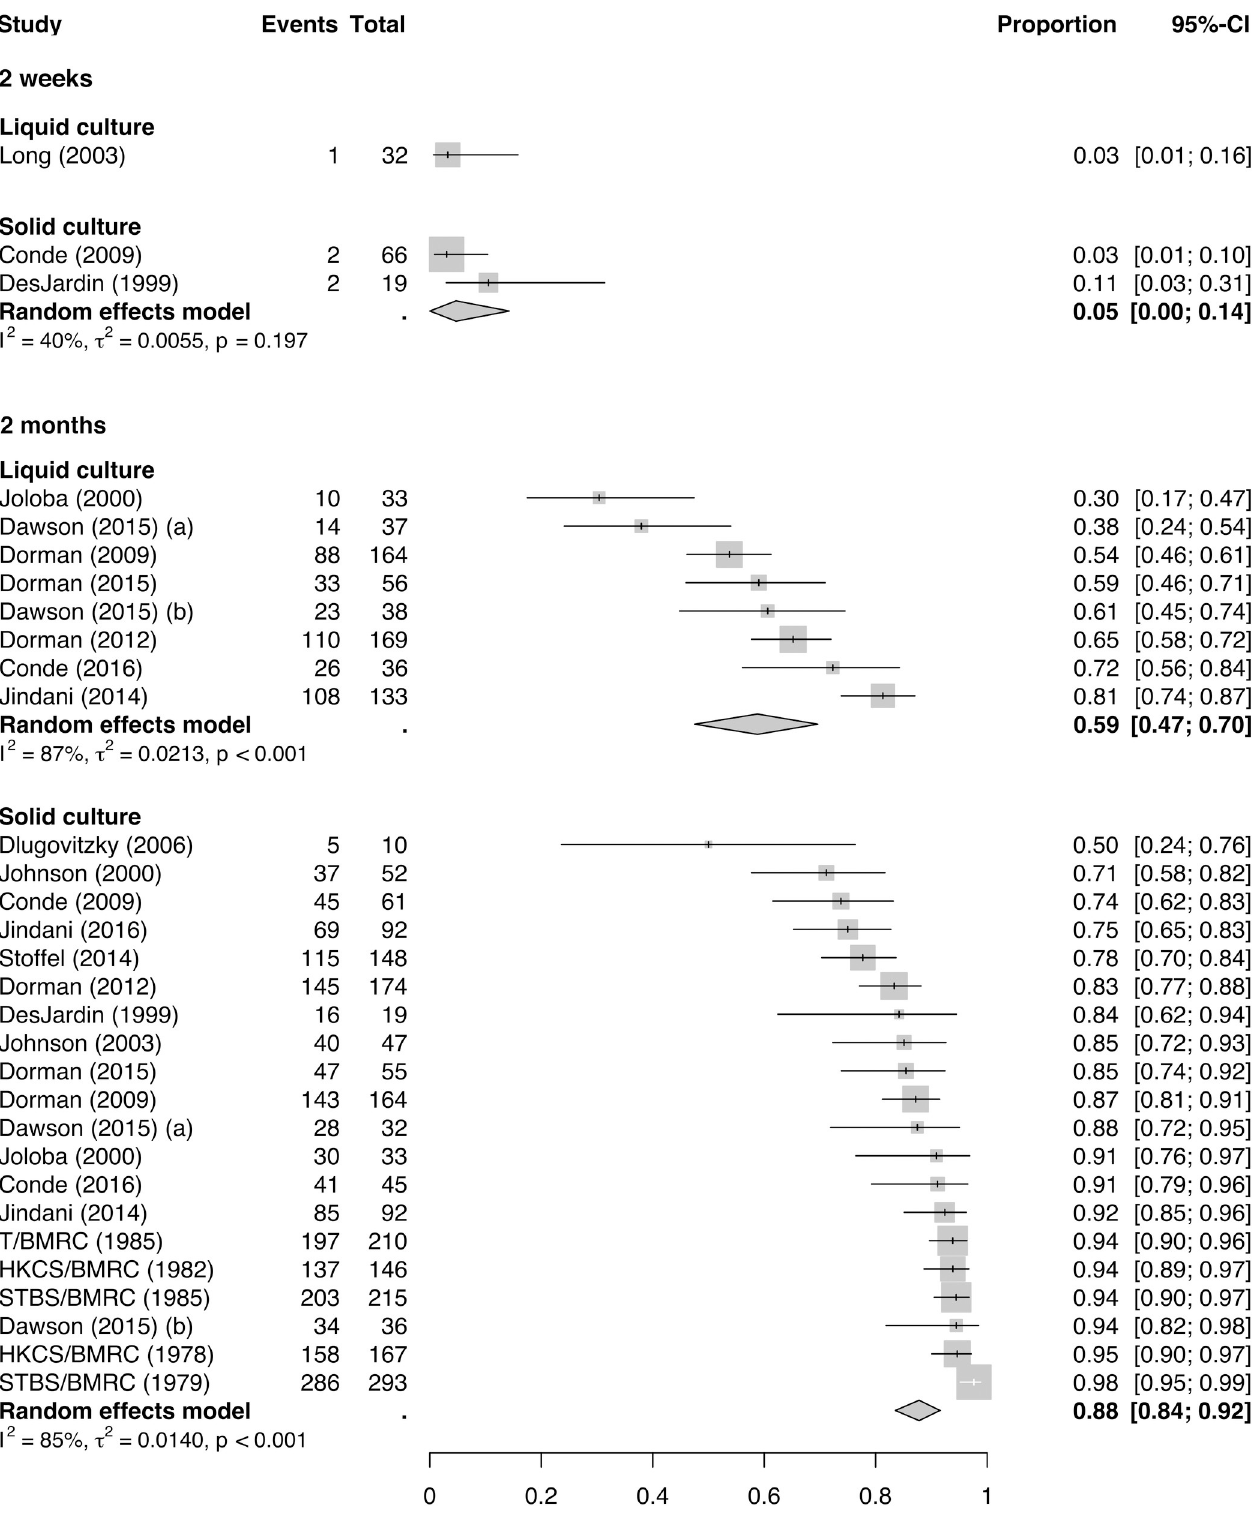
Fig 5. Proportion of baseline smear-positive patients receiving effective treatment for drug-susceptible tuberculosis, achieving solid culture and liquid culture conversion at 2 weeks and 2 months. BMRC, British Medical Research Council; CI, confidence interval; ECA, East and Central African; HKCS, Hong Kong Chest Service; STBS, Singapore Tuberculosis Service; T, Tanzania.